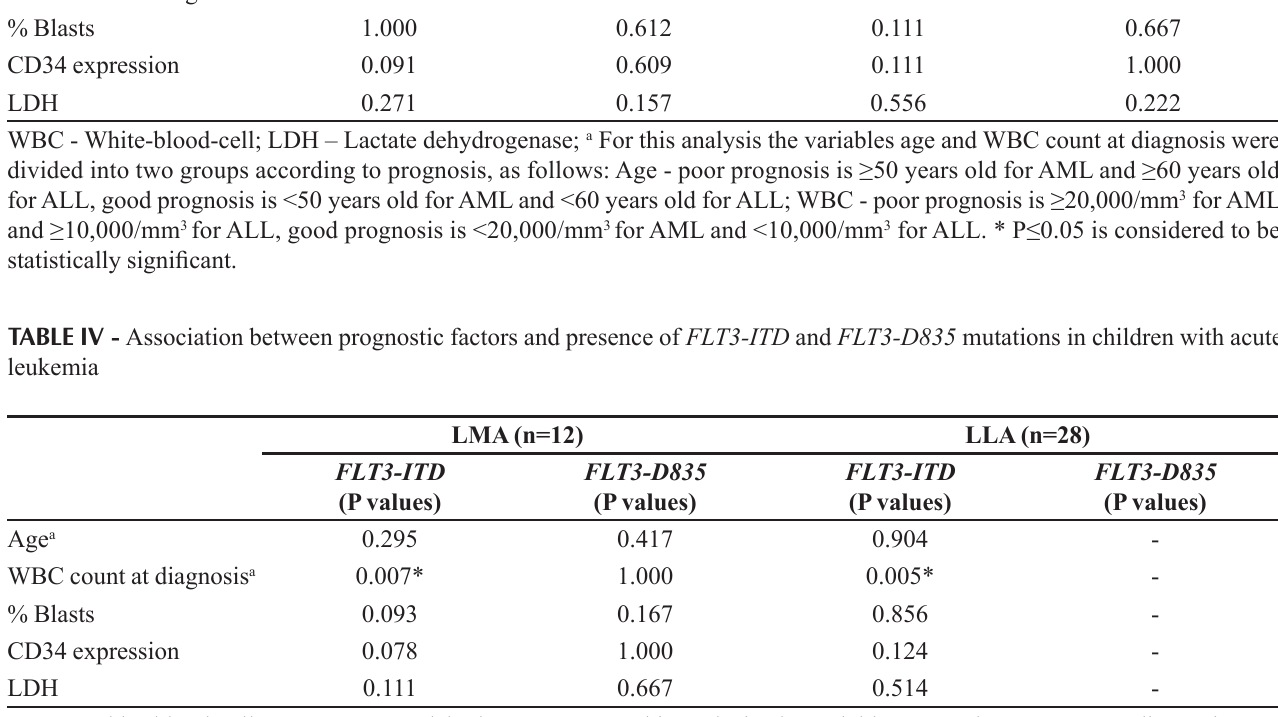
CD34 expression LDH